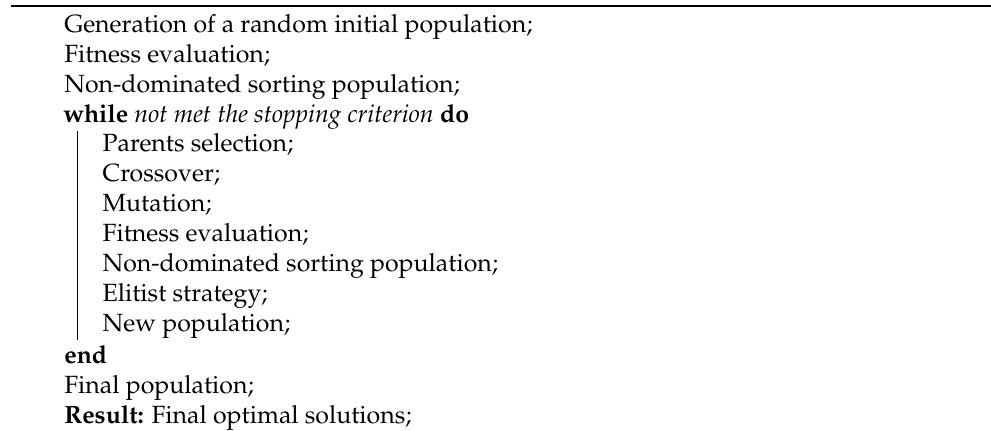
Algorithm 1: Pseudo-code of the Multi-objective Optimization Procedure for Deep Convolutional Architectures using NSGA-II